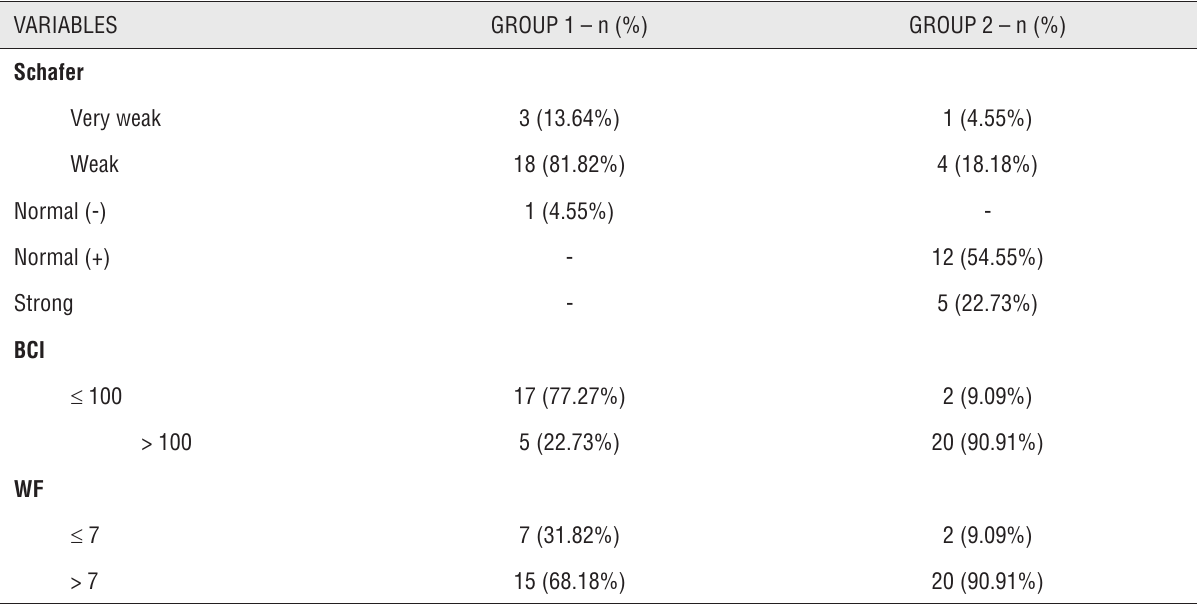
Table 1 - Frequency of urodynamic data: measure of detrusor strength by Schafer Nomogram; values of BCI and WF, considering cut-off point values for Detrusor